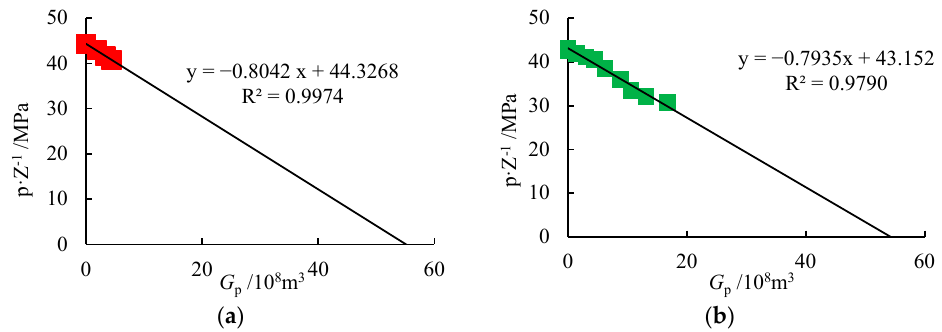
Figure 5. Pressure decline diagram of the pseudo reserves correction method in well B-15. ( a ). Early historical production data; ( b ) Historical production data for the whole period. The relationship curve between F and E t was drawn (Figure 6) according to Equation (17), fitting the gas field dynamic reserves G = 24.254 × 10 8 m 3 ; the current cumulative water influx was W e = 1.2 × 10 5 m 3 .